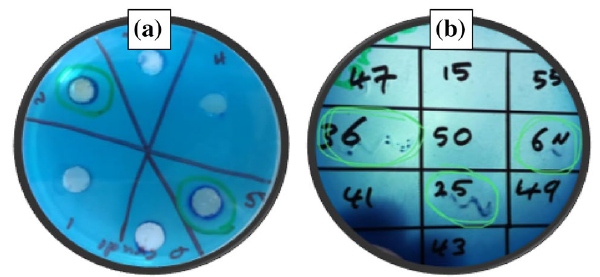
Fig. 5 CTAB agar plate method of different strains: a crude biosur- factant and b isolate colony